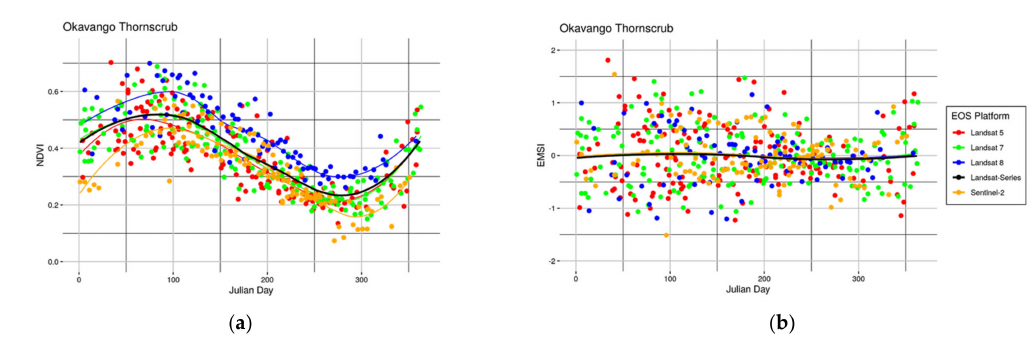
Figure 5. Thirty-four years of NDVI time series for a single pixel ( a ) in the Okavango thornscrub landscape, Botswana. Colors correspond to the Landsat 5, 7, 8 and Sentinel-2 platforms. Lines are the loess moving average, the heavy black line is the average of all the Landsat series measured together. The EMSI time series ( b ) has a mean of approximately zero. In the left panel, note the variation amongst the Landsat 5 and 7 versus 8, which corresponds to long term variability in the NDVI.